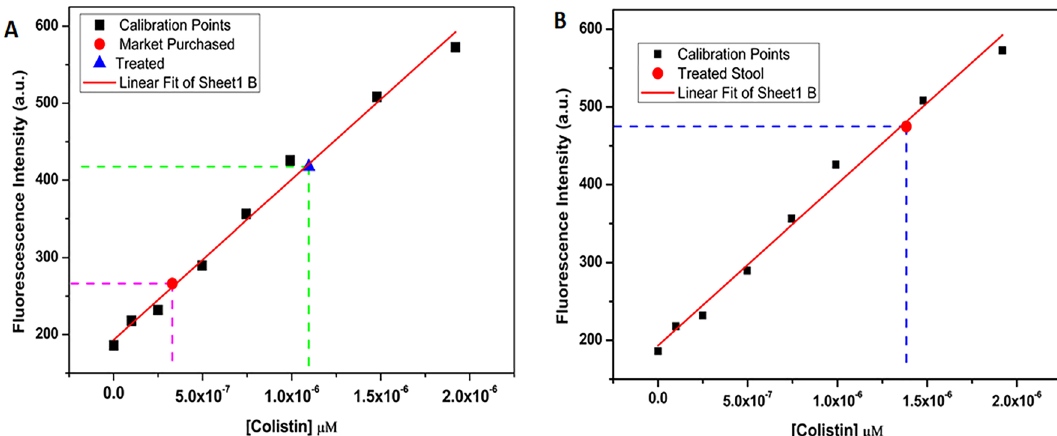
Figure 5. Calibration curve: ( A ) concentration of colistin obtained from hepatocyte cell lysate of market purchased chicken (red), colistin treated chicken (blue) and ( B ) concentration of colistin from the manure (stool and urine) of treated chicken.